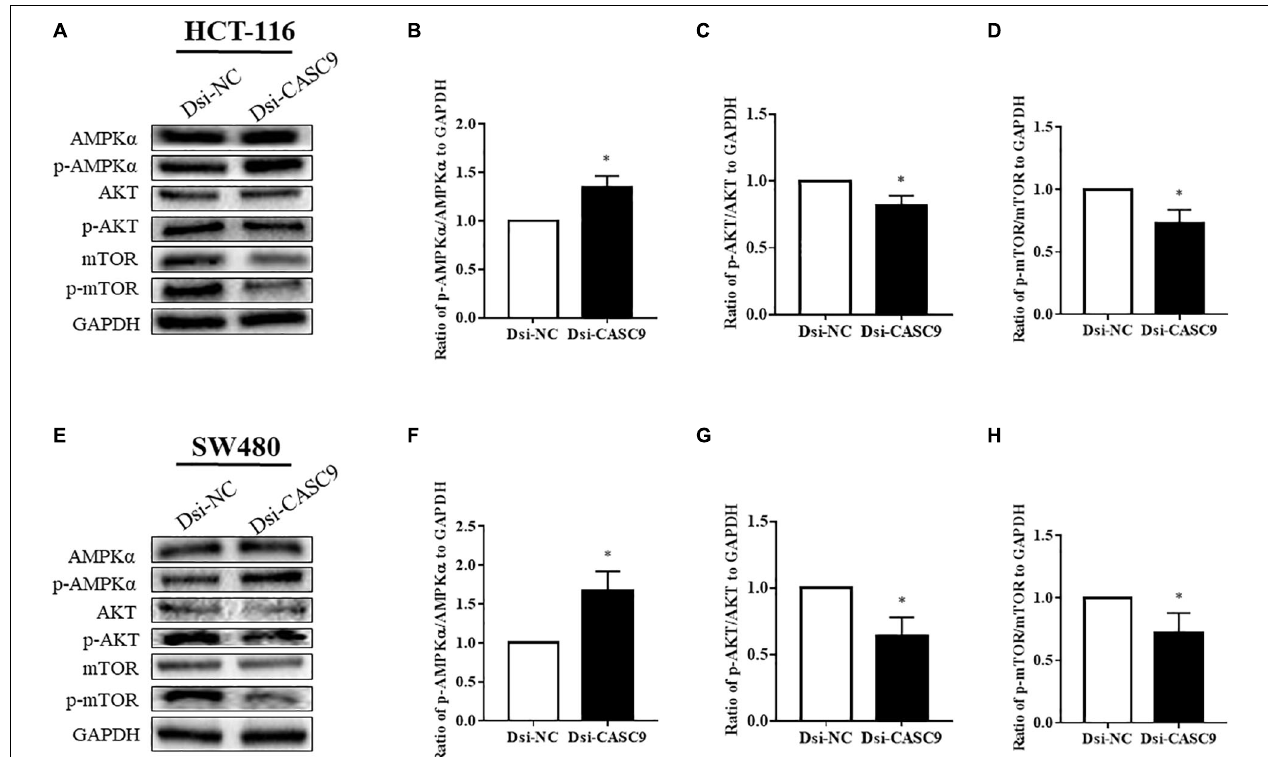
FIGURE 5 | Silencing of CASC9 promoted the AMPK signaling pathway but downregulated the AKT and mTOR pathways. The ratio of p-AMPK α /AMPK α , p-AKT/AKT, and p-mTOR/mTOR to GAPDH were evaluated by Western blotting in HCT-116 (A–D) and SW480 cells (E–H) . Dsi-CASC9 significantly promotes AMPK signaling in HCT-116 and SW480 cells compared to Dsi-NC. In contrast, CASC9 silencing significantly downregulated AKT and mTOR signaling pathways in HCT-116 and SW480 cells. The data are shown as mean ± SEM using GAPDH as housekeeping gene (* P < 0.05, and n =